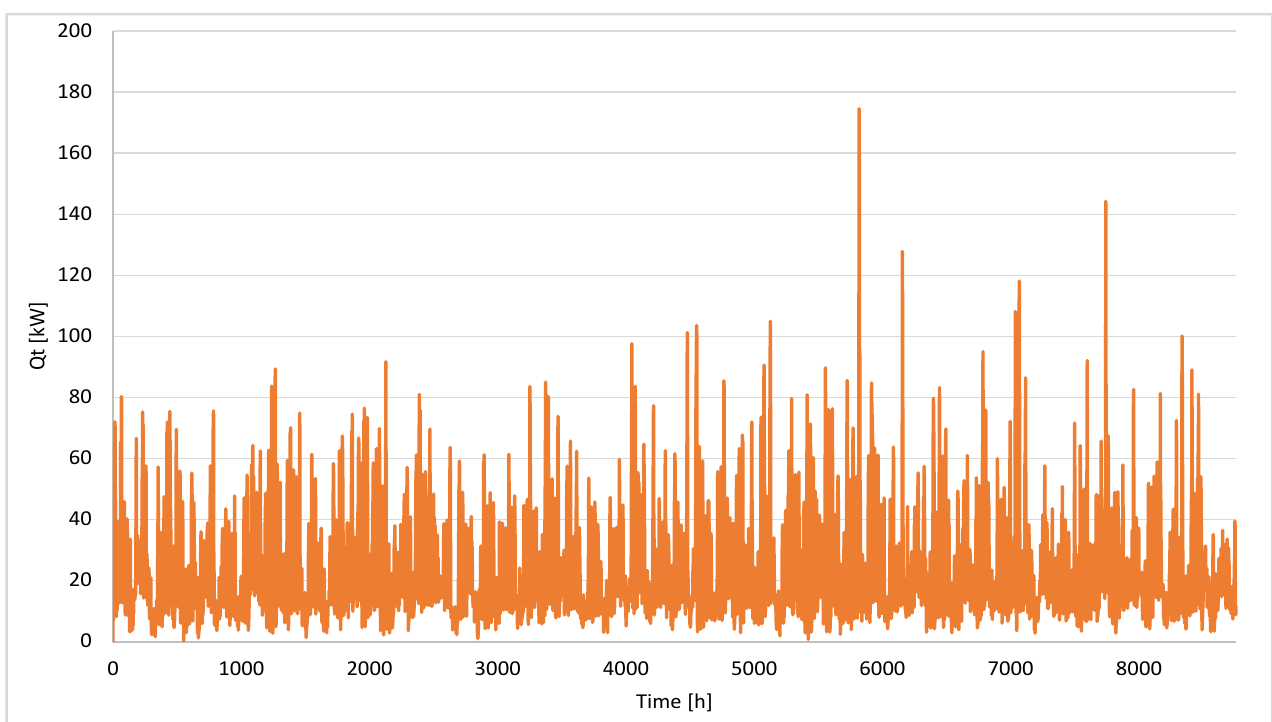
Figure 15. Total heat transfer obtained from TRANSYS model.